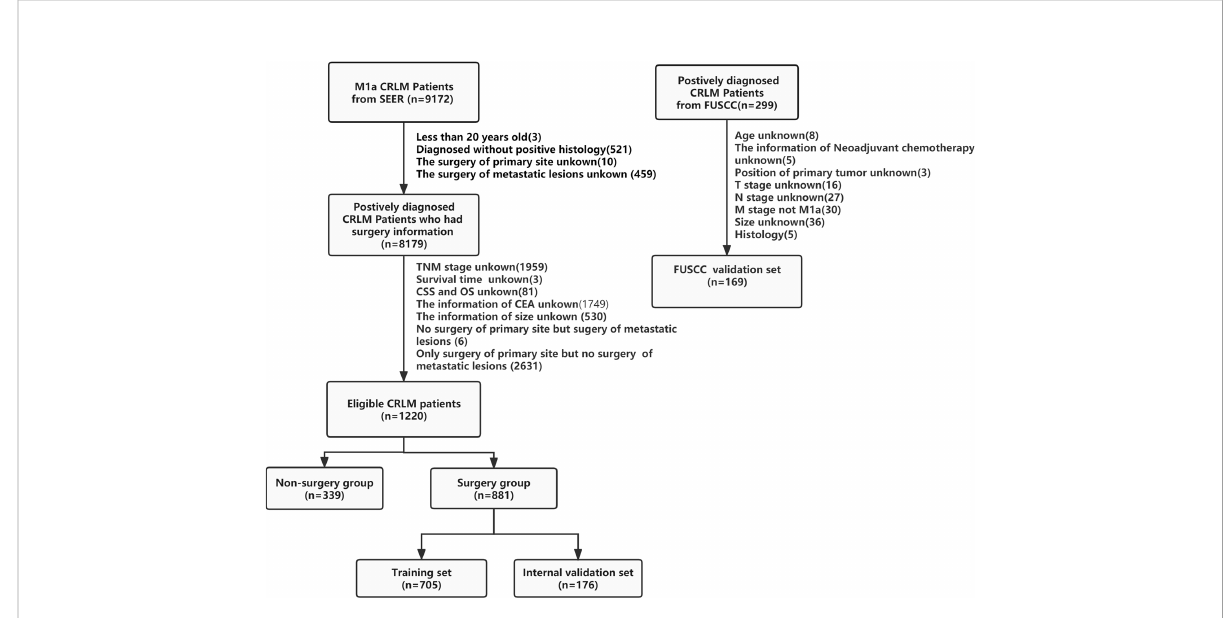
FIGURE 1 Flowchart of the data selection